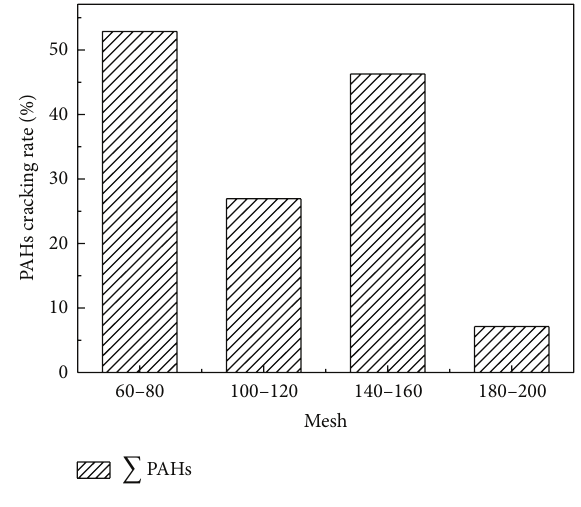
Figure 4: Relationship between the total PAHs cracking rate and particle size of